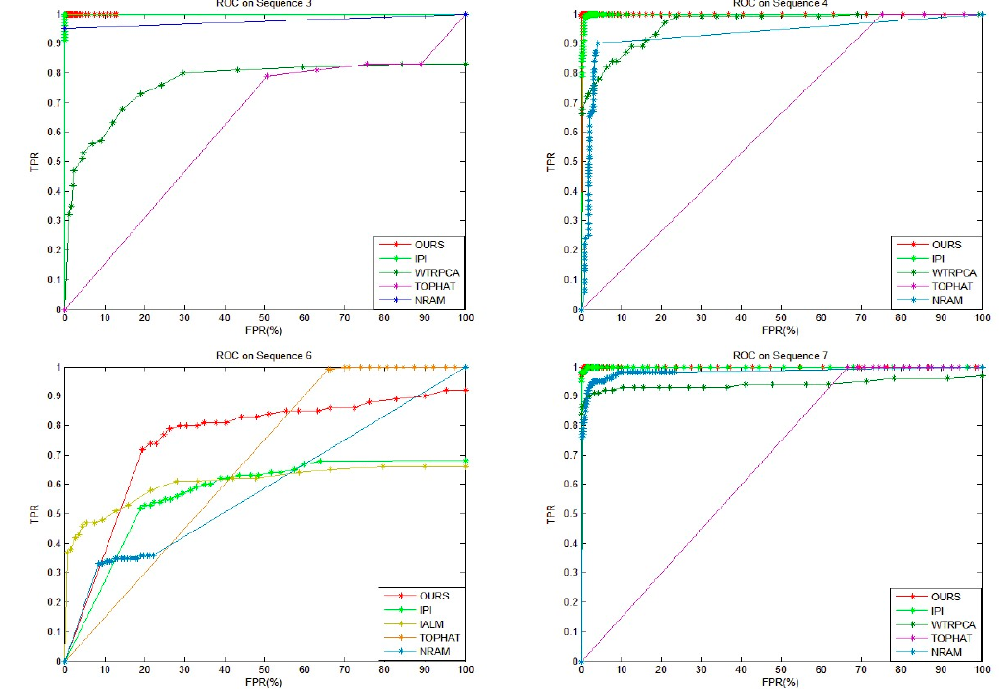
Figure 10. ROC curves of four representative sequences. Table 6. Calculation times of representative scenes. (Unit: